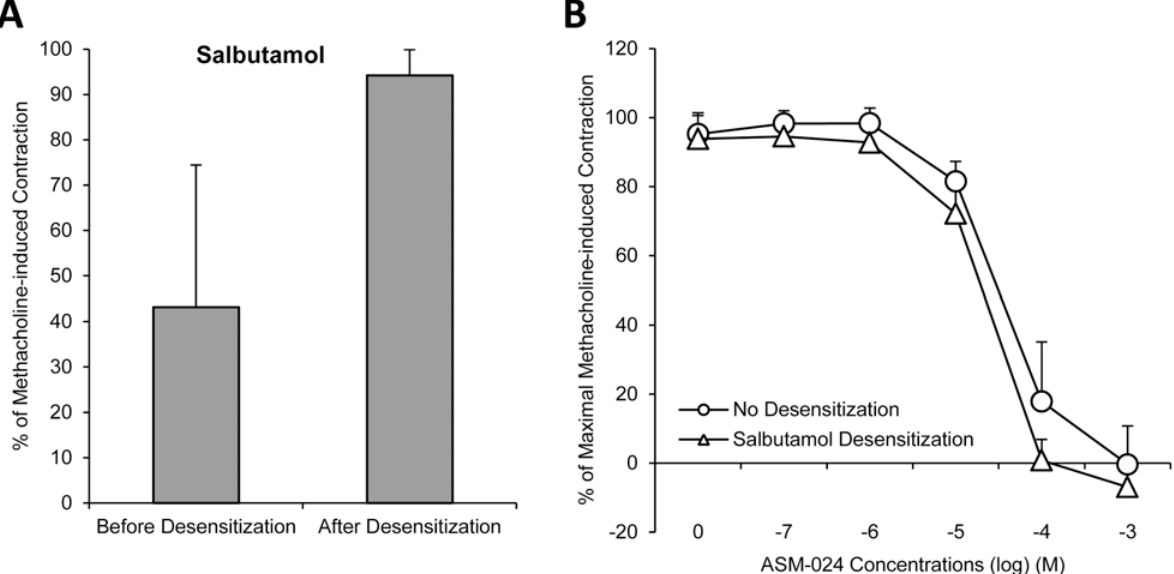
Fig 2. Relaxant Effects of ASM-024, on Salbutamol Desensitized Guinea-Pig Tracheas. A) Intact guinea pig tracheas were studied before or after 4 h of exposure to the β 2 agonist salbutamol. A reduced relaxation response to the β 2 agonist was observed after 4 hour exposure to salbutamol (p < 0.05). B) No significant difference was observed on the relaxation response curves of ASM-024 on intact or salbutamol desensitized tracheas. EC50 = 40 ± 9 μ M for intact tracheas; EC 50 = 25 ± 11 μ M for desensitized tracheas; values are means ± SD, n = 4.